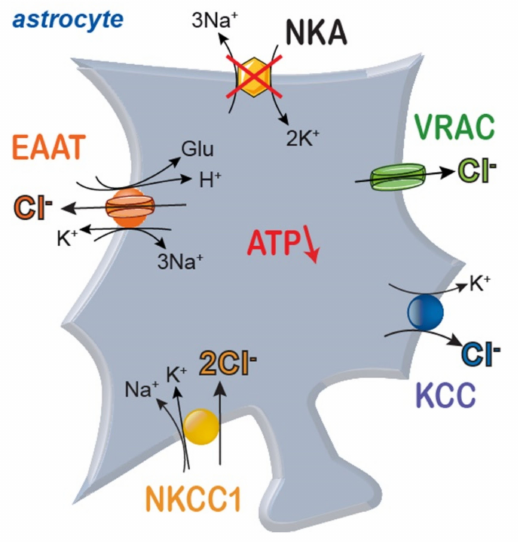
Figure 4. Scheme of main pathways for transport of Cl − across astrocyte membranes. NKA: sodium/potassium-ATPase; NKCC1: sodium-potassium-2 chloride cotransporter 1; EAAT: exci- tatory amino acid transporter; KCC: potassium-chloride cotransporter; VRAC: volume-activated anion